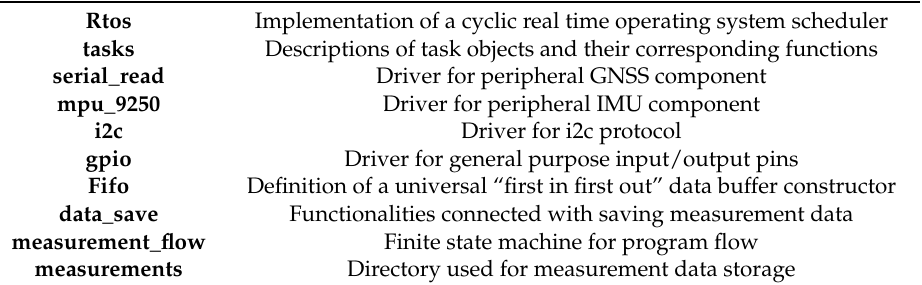
Table 4. Application